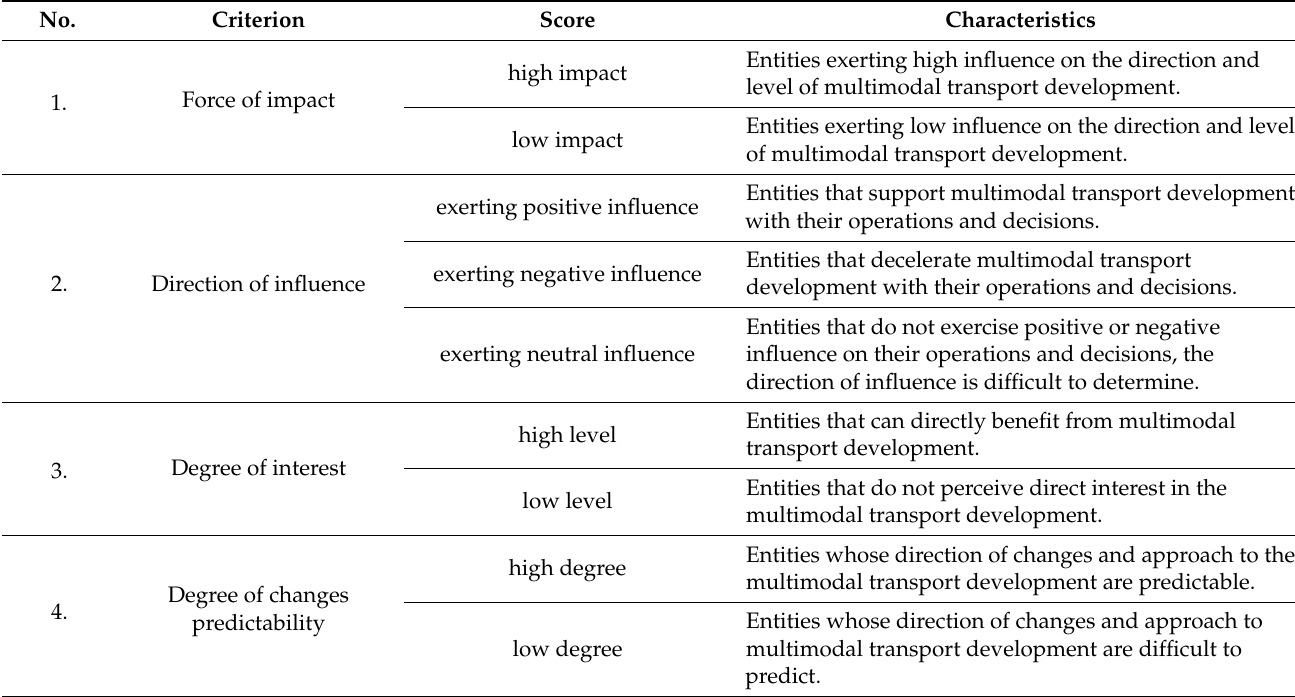
Figure 2. Types of ecosystems in the holistic multimodal transport ecosystem (own study). Table 2. Stakeholder characteristics criteria.